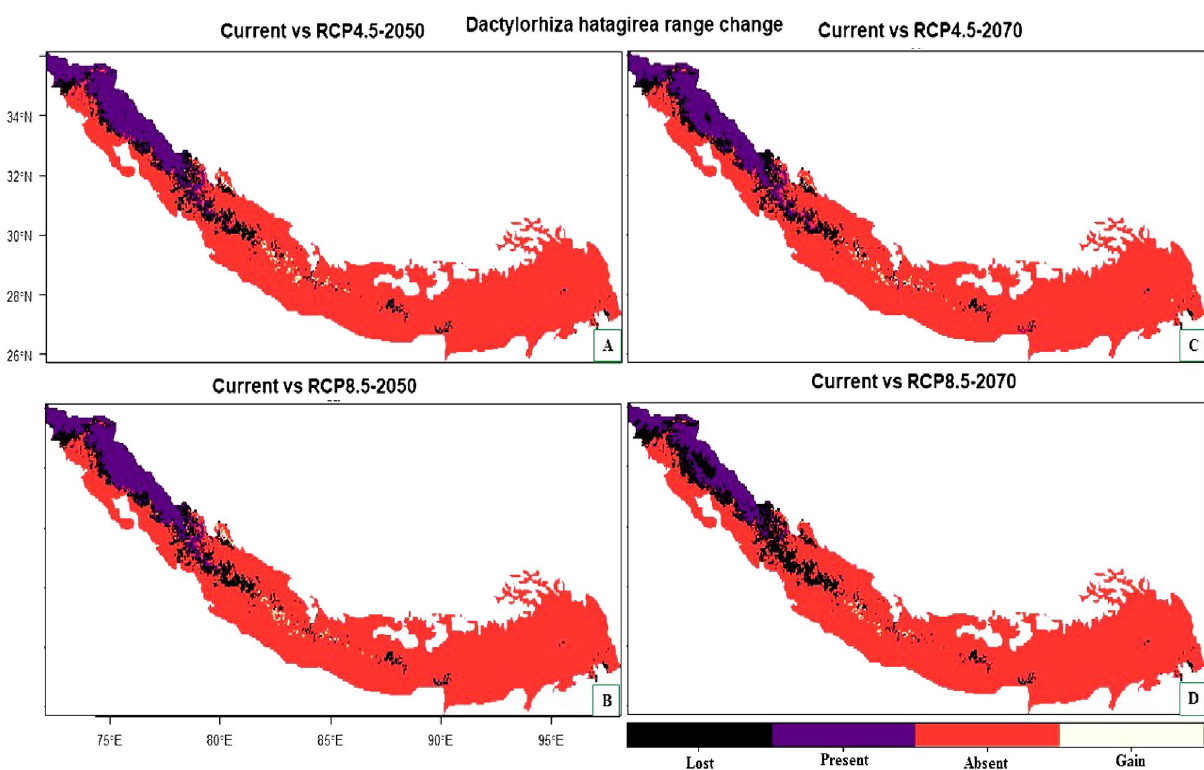
Figure 6. ( A – D ) Plot of the predicted range changes for Dactylorhiza hatageria between current and future climatic conditions. ( A ) Current VS RCP 4.5 (2050) ( B ) Current VS RCP 8.5 (2050) ( C ) Current VS RCP 4.5 (2070) ( D ) Current VS RCP 8.5 (2070). In scale, black color shows the areas where habitat suitability is predicted to be lost in the future, purple color shows the regions that maintain the habitat suitability in the future climatic scenarios, red color shows the regions where the species is absent while olive color in the scale represents the areas where newly suitable habitats are predicted to appear in the future climate scenarios.